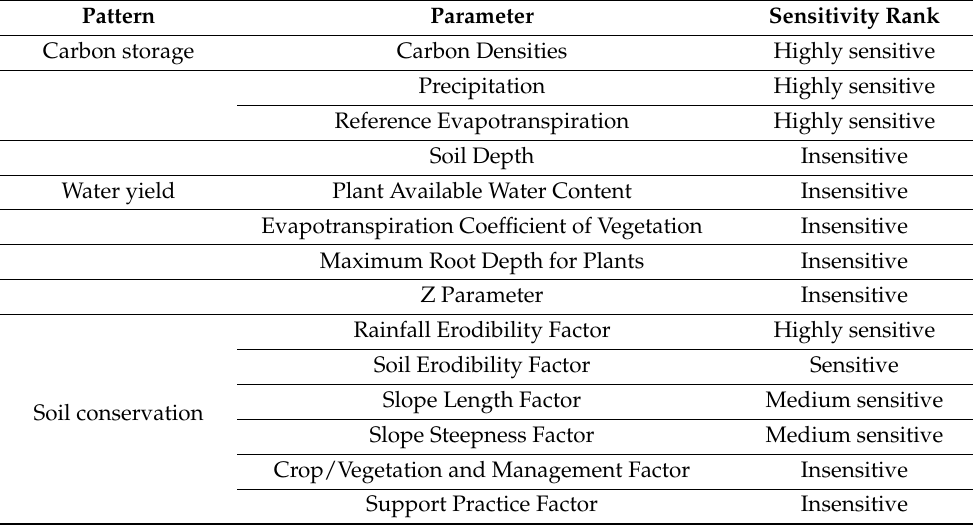
Table 4. Sensitivity rank of parameters to